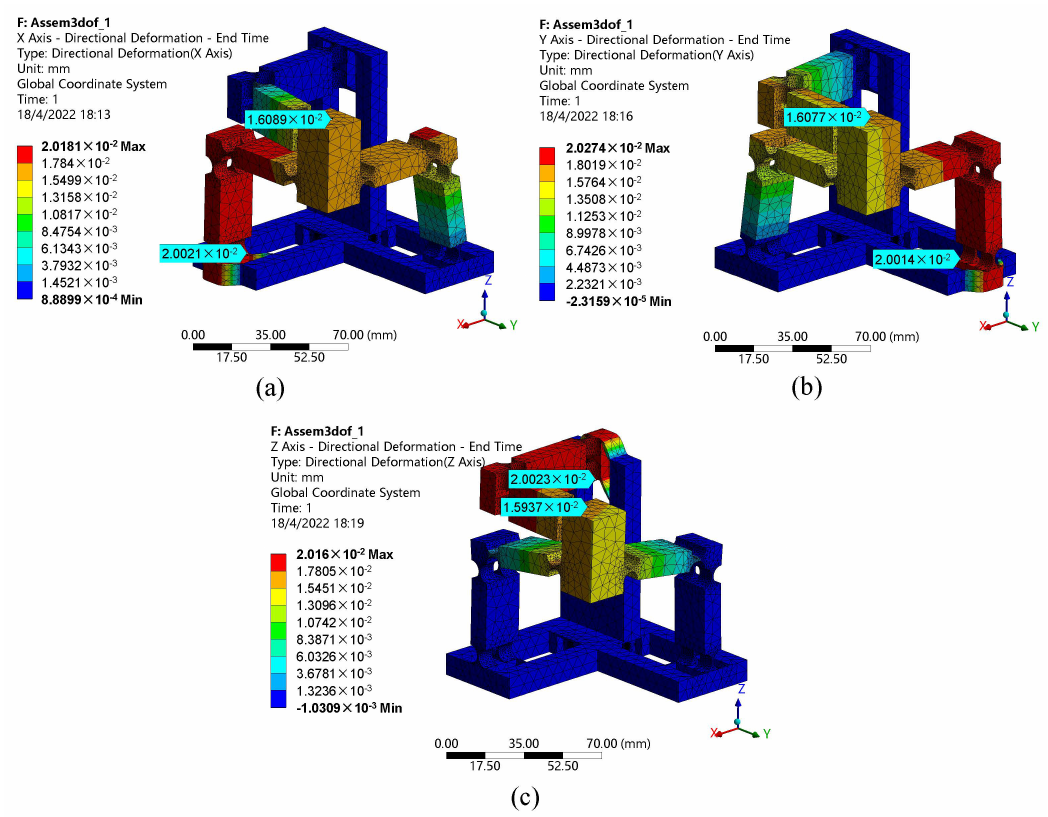
Figure 9. The corresponding output displacement of the motion platform with a 20 µ m input on different axes: ( a ) x -axis, ( b ) y -axis, ( c ) z -axis.